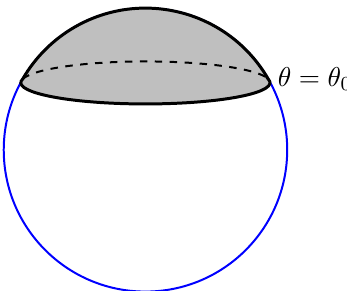
Figure 4. Intersection of RT surface with the boundary at θ = θ 0 . Polar cap 0 ≤ θ ≤ θ 0 is shown as the region shaded in